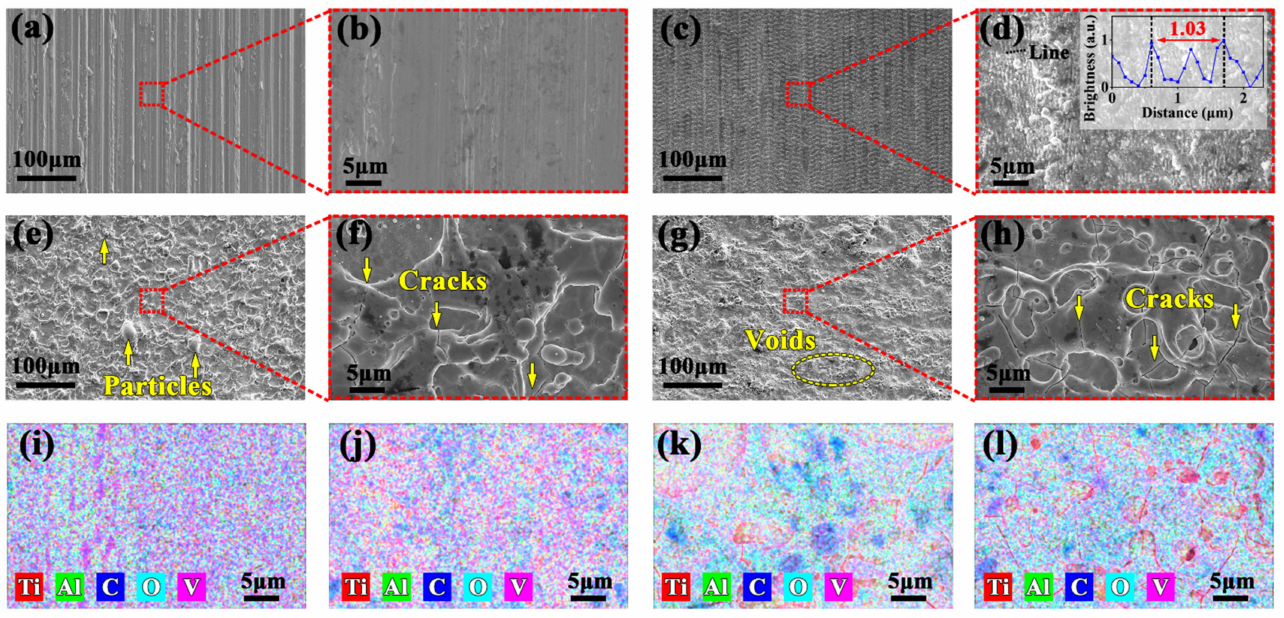
Figure 2. Surface microstructural changes of un-treated and LSPed surfaces. Surface microstructures of ( a ) un-treated, ( c ) FLSPed, ( e ) NLSPed, and ( g ) F-NLSPed samples, ( b , d , f , h ) show the correspond- ing enlarged view in the selected areas; Surface elements mappings of ( i ) un-treated, ( j ) FLSPed, ( k ) NLSPed, and ( l ) F-NLSPed